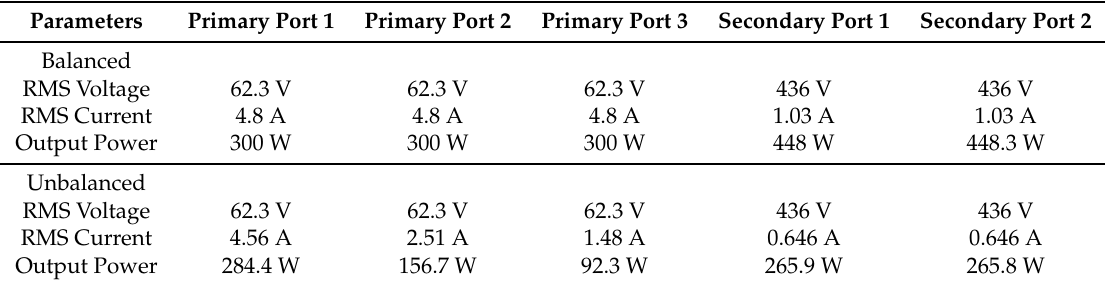
Table 2. Simulation results.